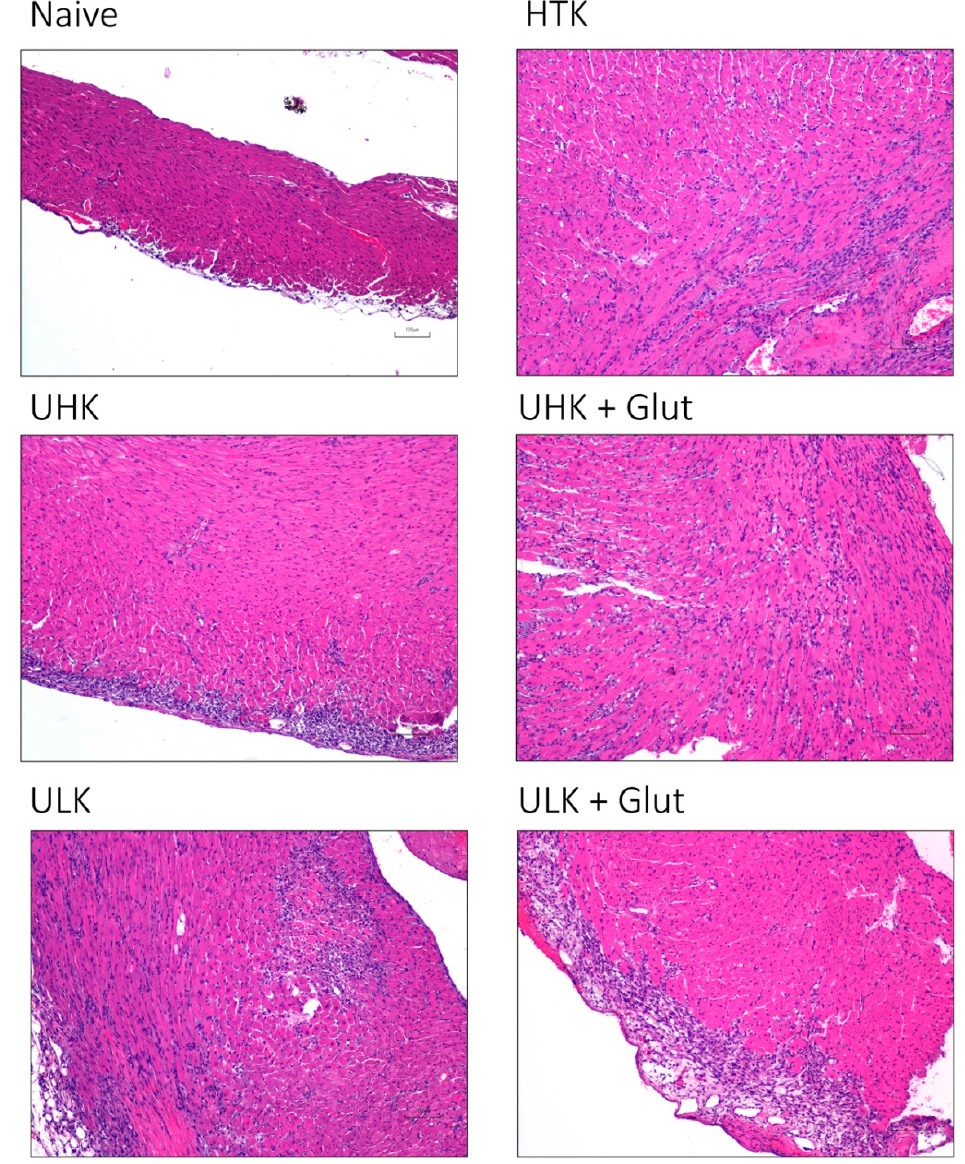
Figure 4. Histomorphologic assessment of cardiac tissue after heterotopic transplantation using H&E staining. Representative images of H&E-stained cardiac tissue sections taken on POD three after heterotopic heart transplantation (scale bar 100 µm, 10× magnification). Unisol, gluconate- lactobionate-dextran; HTK, histidine-tryptophan ketoglutarate solution; UHK, Unisol-high-potassium; ULK, Unisol-low-potassium; Glut, glutathione.